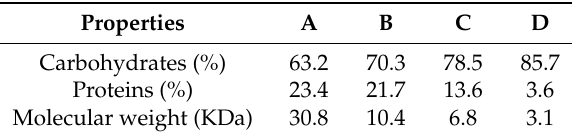
Figure 2. Purification of ITG on Sephadex G-50 column.